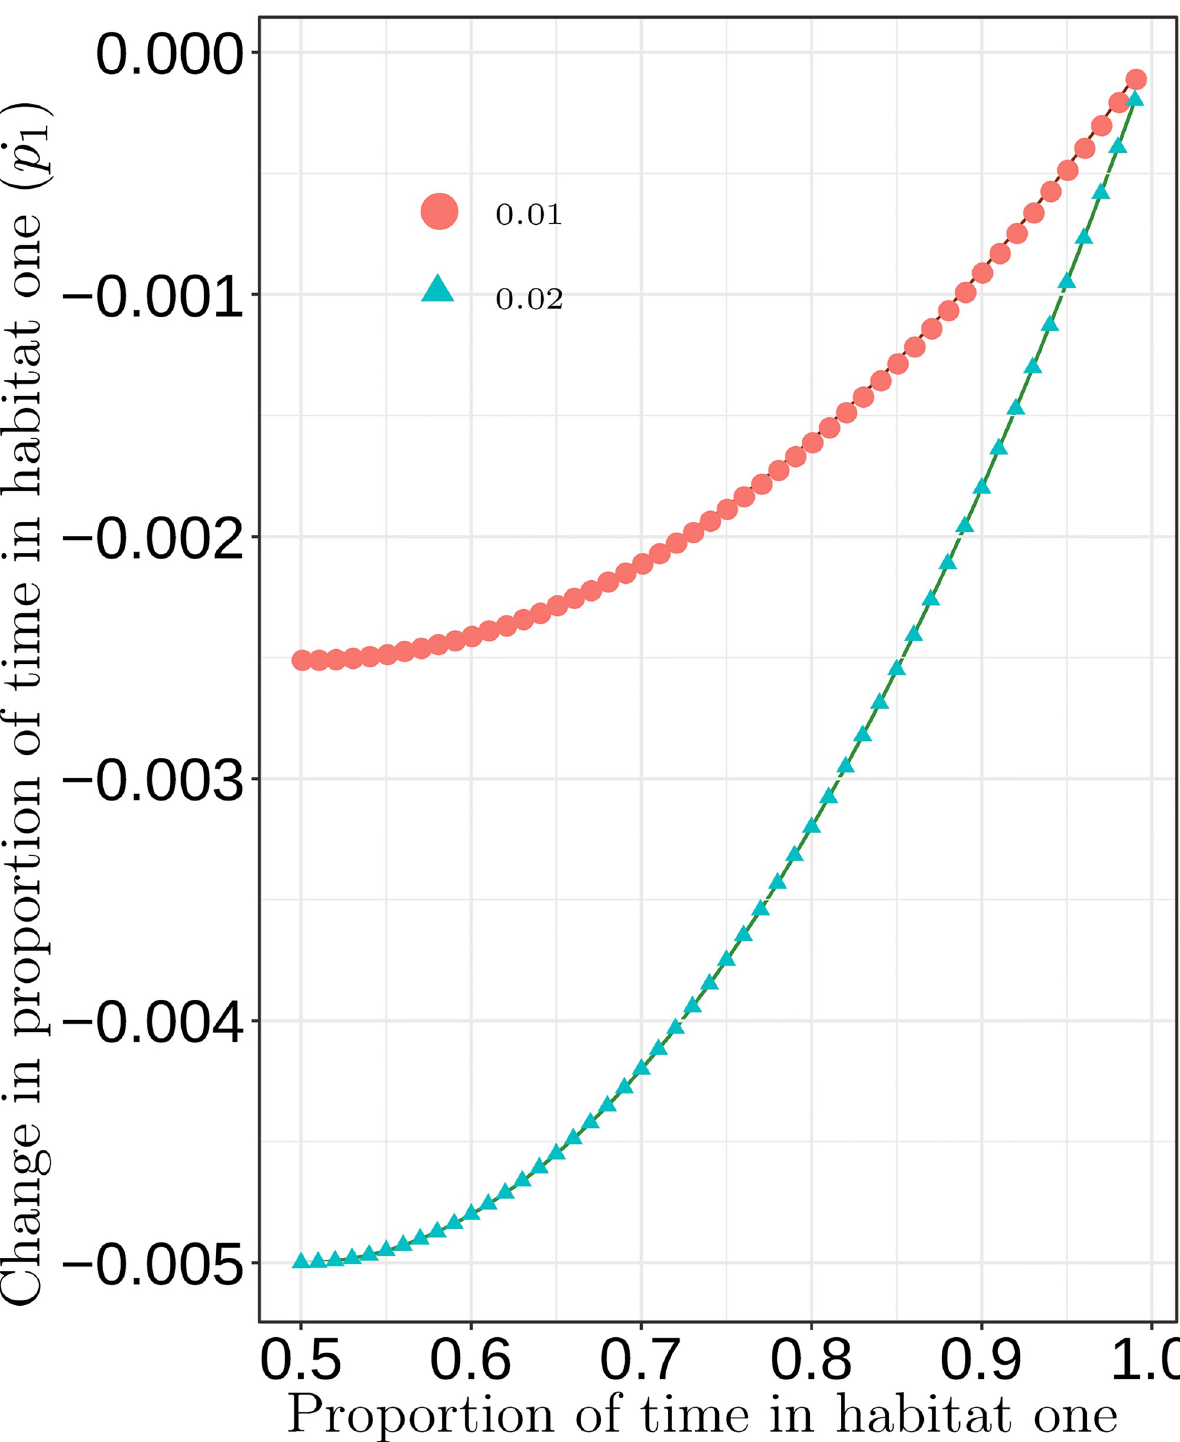
Fig 10. Illustration of how the proportion of time in a habitat moderates the effect of normalized differences in harvest per unit effort upon the change in proportion of time devoted by the group one forager to habitat one. In this case, harvest per unit effort is higher in habitat two than habitat one at two constant levels: 0.01 (orange dots) and 0.02 (blue triangles). Thus, the group one forager decreases the proportion of time spent in habitat one (y-axis), and this is moderated by the current balance of time spent in habitat one (x-axis). As the proportion of time spent in habitat one decreases, the forager discounts the potential value of resources in habitat two less and adjusts her balance of time away from habitat one more strongly.